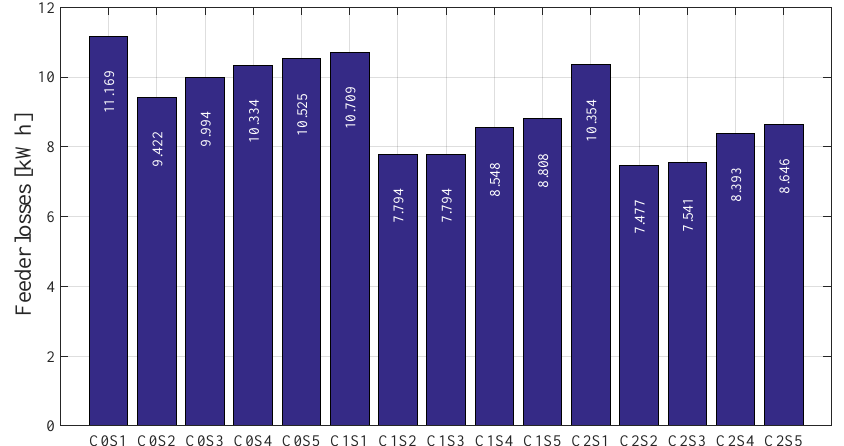
Figure 12. Feeder losses depending on the examined case